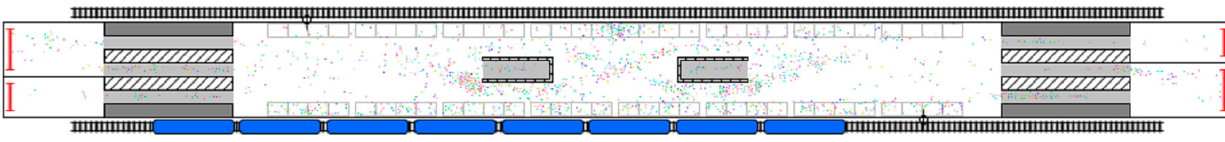
Figure 24. Passengers board the train.